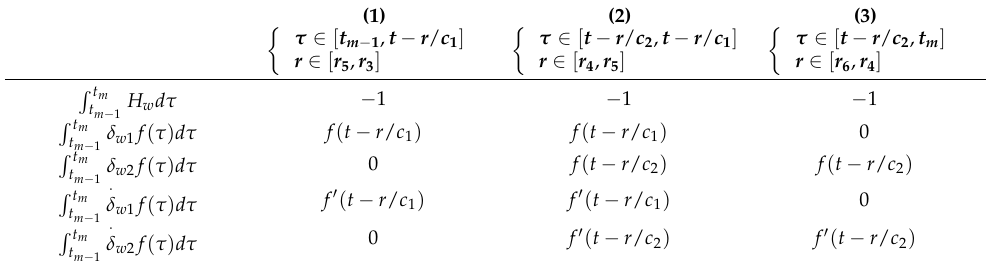
Table 2. Integration results of H w , δ w 1 , δ w 2 ,